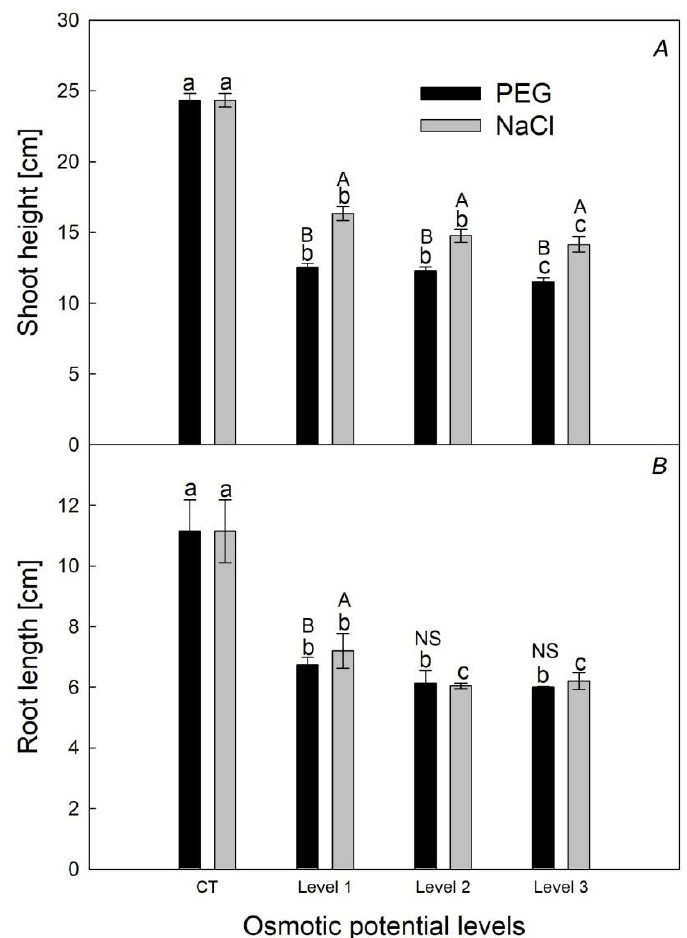
Figure 1. Means ± SD (n = 5) of shoot height (A) and root length (cm) (B) from seedlings grown under three iso-osmotic potential levels under separate polyethylene glycol (PEG) and sodium chloride (NaCl) treatments. Level 1: 24% (w/v) PEG and 200 mM NaCl; Level 2: 26.5% (w/v) PEG and 250 mM NaCl; Level 3: 29% (w/v) PEG and 300 mM NaCl. Non-treated control (CT) shown twice was easy for the identification of NaCl and PEG treatment. Means with different lowercase letters significantly differ in a least significant difference (LSD) test under different PEG or NaCl concentrations, respectively ( p < 0.05). Means with different capital letters significantly differ in a t -test between PEG and NaCl concentration at the same osmotic potential.